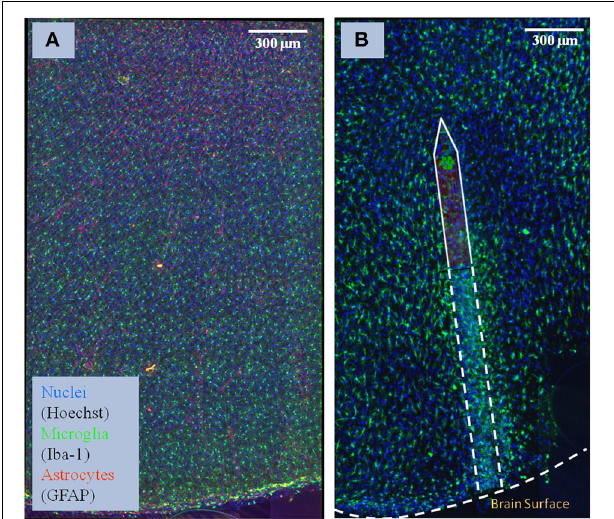
FIGURE 1 | Sample of brain tissue images used to study the impact of implanted neuro-prosthetic devices. (A) Maximum-intensity projection of a multi-channel confocal montage of normal rat brain tissue, and (B) tissue after 1 month of implantation of the neuro-prosthetic device. An outline of the device is shown in the picture to demonstrate how different the tissue is near the device compared to far away from the device. Blue color represents the Nuclei channel, green represents the Microglia channel, and red represents the Astrocyte channel. This image illustrates the complexity and size of the image data required to be processed by our